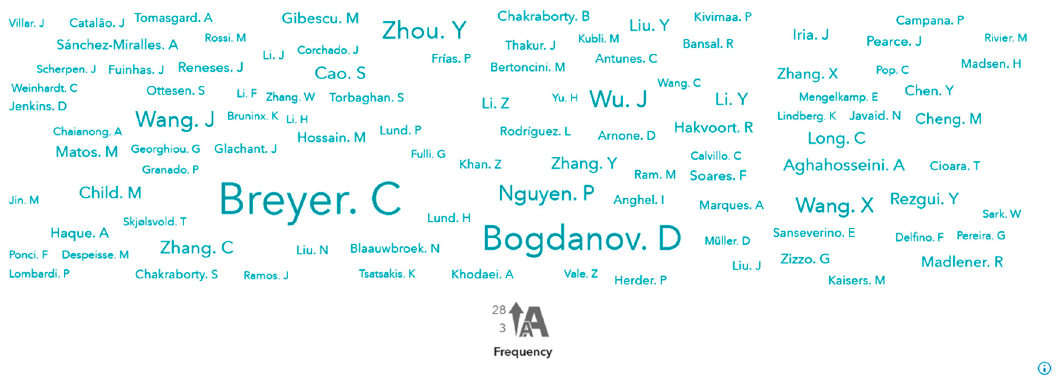
Figure 4. Most prevalent authors.